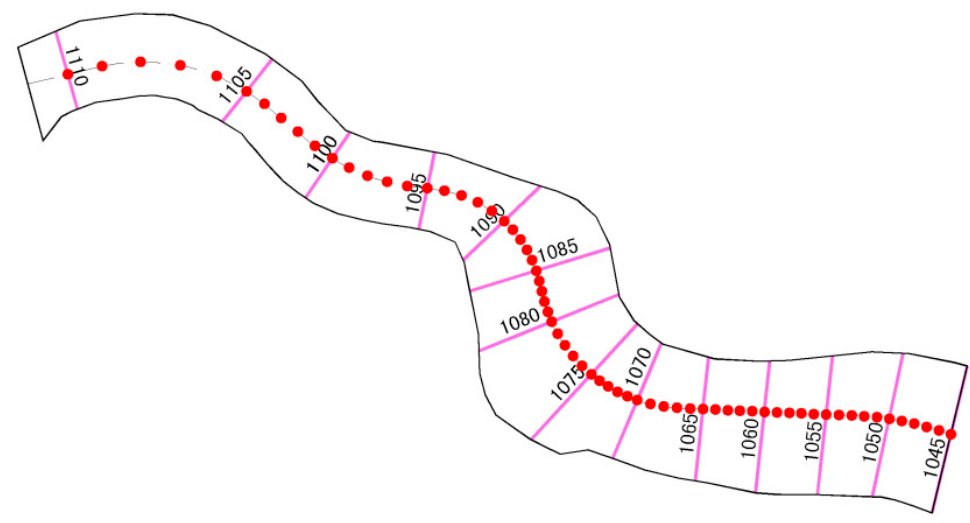
Figure 8. The points with a 1 m contour distance on the centerline by using linear interpolation.